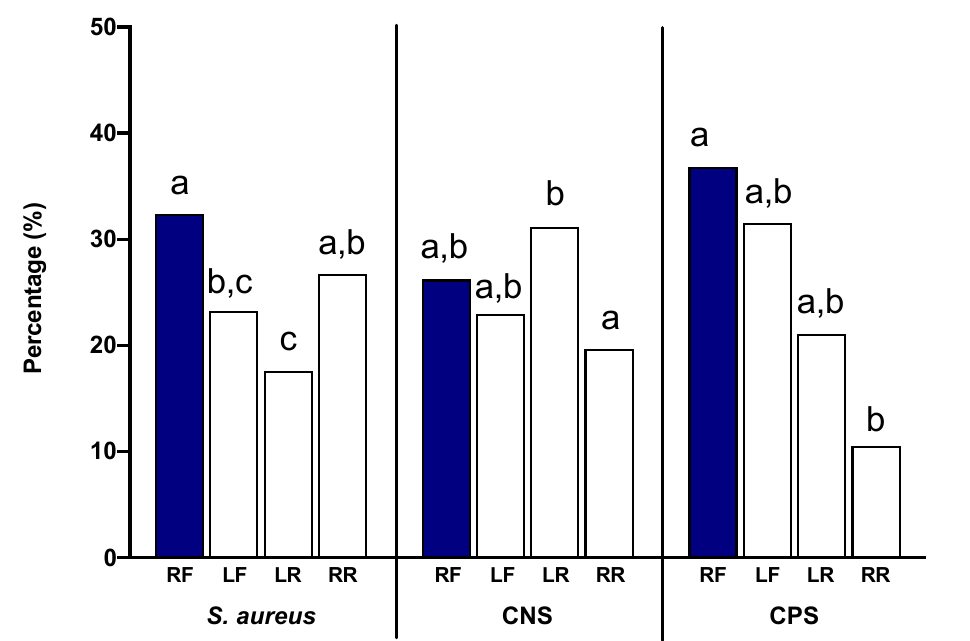
Figure 4. Distribution of non-hemolytic S. aureus , CNS, and CPS infection among quarters. Letters above bars represent differences within each pathogen group. Letters that are similar are not different ( p > 0.05), whereas letters that differ are significantly different ( p < 0.05).